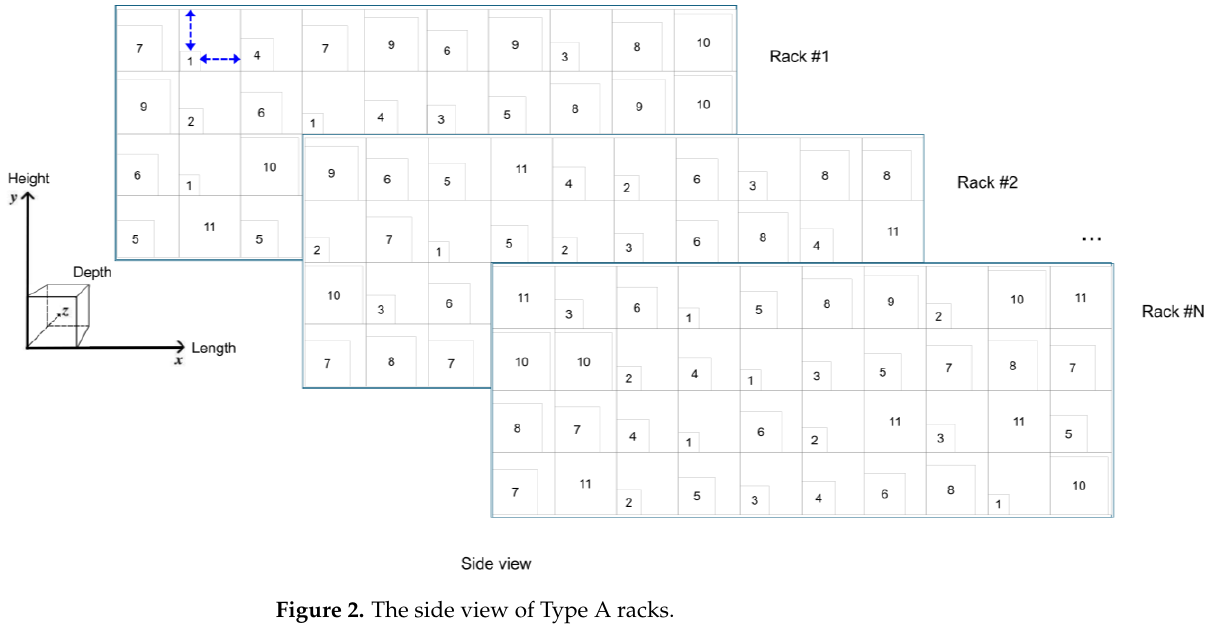
Figure 2. The side view of Type A racks.